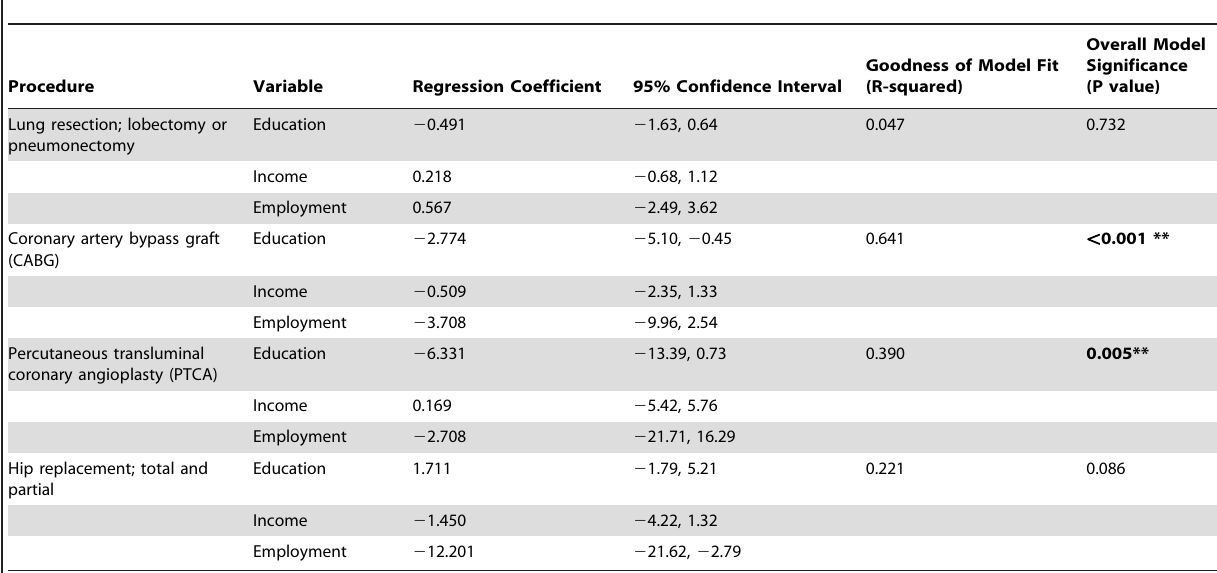
Table 4. Multiple linear regression analysis of socioeconomic